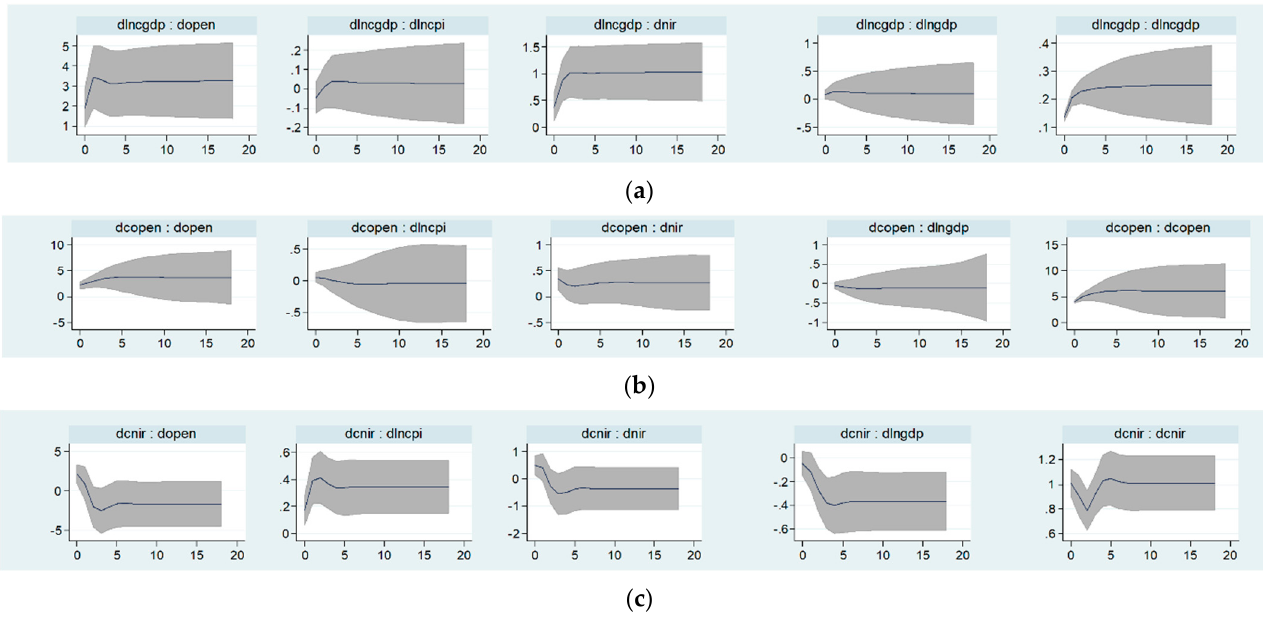
Figure 3. Impulse − Response Functions of BRI’s Variables. Note: Plots are 95% confidence interval with cumulative orthogonalised IRF. It can be seen as an impulse response. ( a ) China Income (GDP) Shock. ( b ) China Trade Shock. ( c ) China Interest Rate Shock.